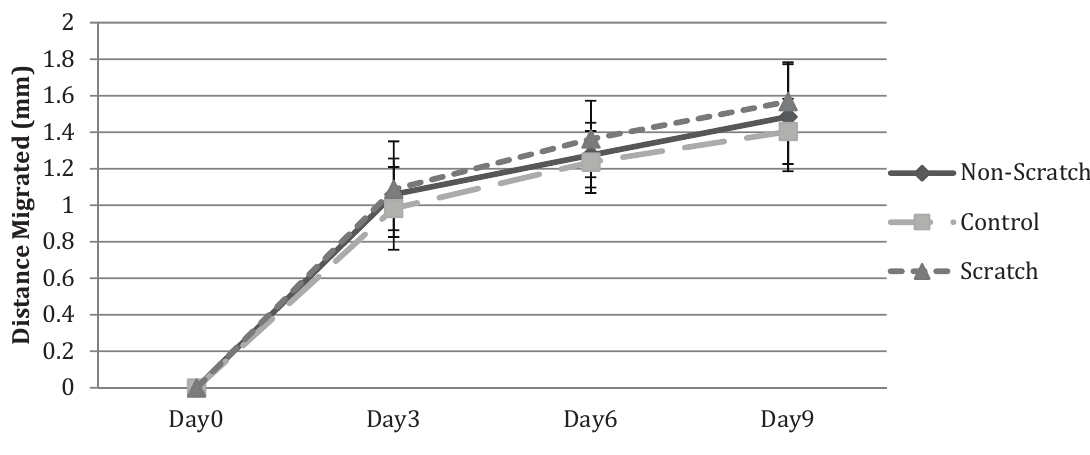
Figure 5. Three-dimensional wound migration assay. Fibroblast migration from collagen to a collagen defect with two medium conditions (non-scratch and scratch). Distance migrated measured in ImageJ as the distance between the wound edge and the leading edge of cell migration.